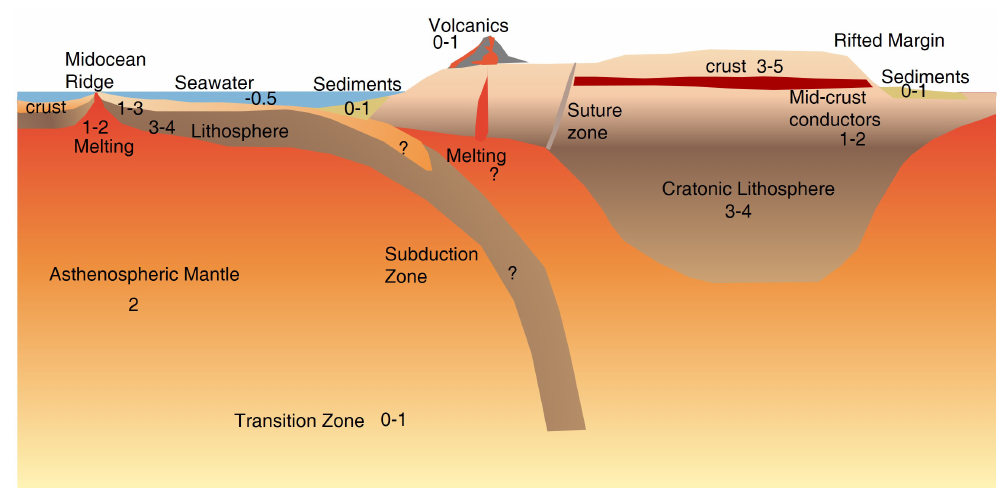
Figure 1. A cartoon showing key features of crust and upper mantle and their typical ranges of resistivity with numbers denoting resistivity in log